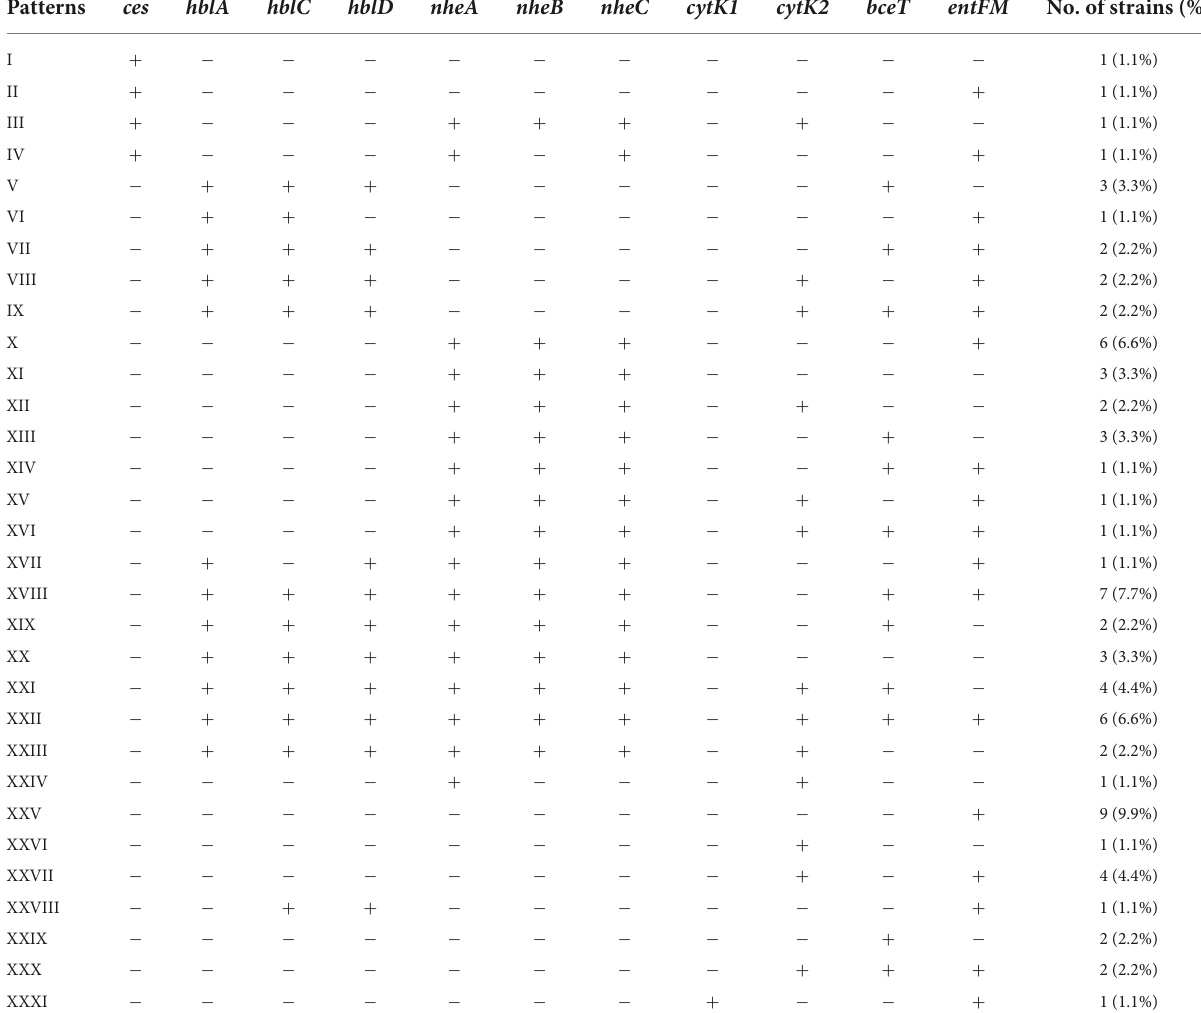
TABLE 2 Virulence genes distribution profile of bacillus cereus isolates. Patterns